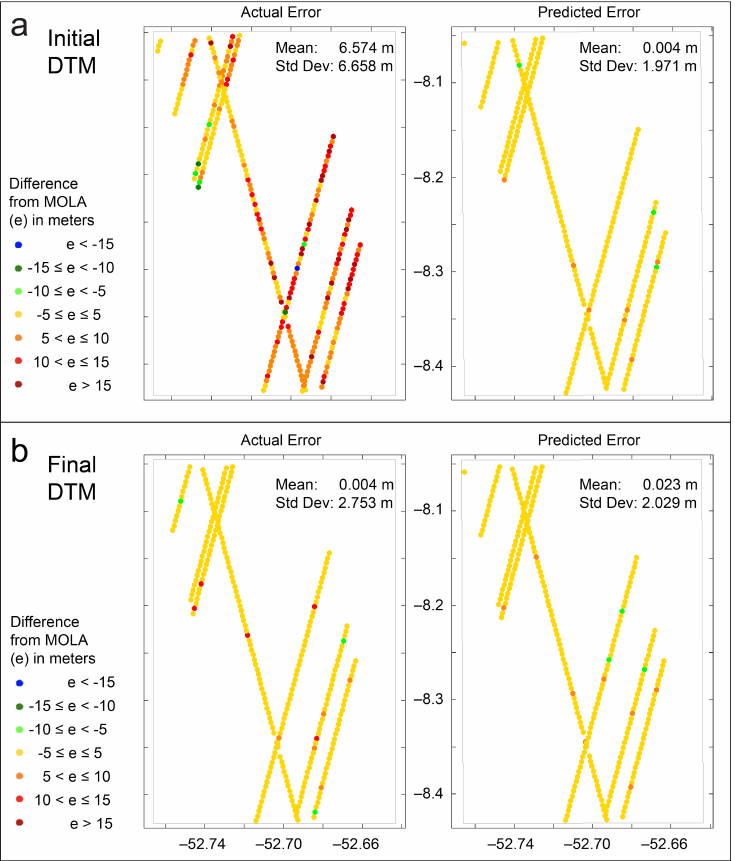
Figure 5. Error maps output from autoTriangulation . Dots represent the difference in elevation in meters between individual MOLA PEDRs and the corresponding location in the HiRISE DTM (not ren- dered). Dots are color-coded in 5-m increments, with yellow indicating the desired error range of 0 to ± 5 m. Horizontal and vertical axes are longitude and latitude, respectively. The left panels (“Actual Error”) show the measured differences in elevation between MOLA and the HiRISE model. The right panels (“Predicted Error”) show the elevation differences after translation and rotation of the HiRISE model within autoTriangulation to achieve a minimum RMS error: ( a ) Actual error after the initial (relative +Z-control) solution from SOCET Set, and the corresponding predicted error from autoTrian- gulation . ( b ) Error maps after applying the transformation from autoTriangulation to the control points in SOCET Set and generating a new DTM. The actual error and the predicted error now agree closely, and the actual error is within the expected range. At this point, the solution is considered acceptable and the MST step is completed. Error maps shown for